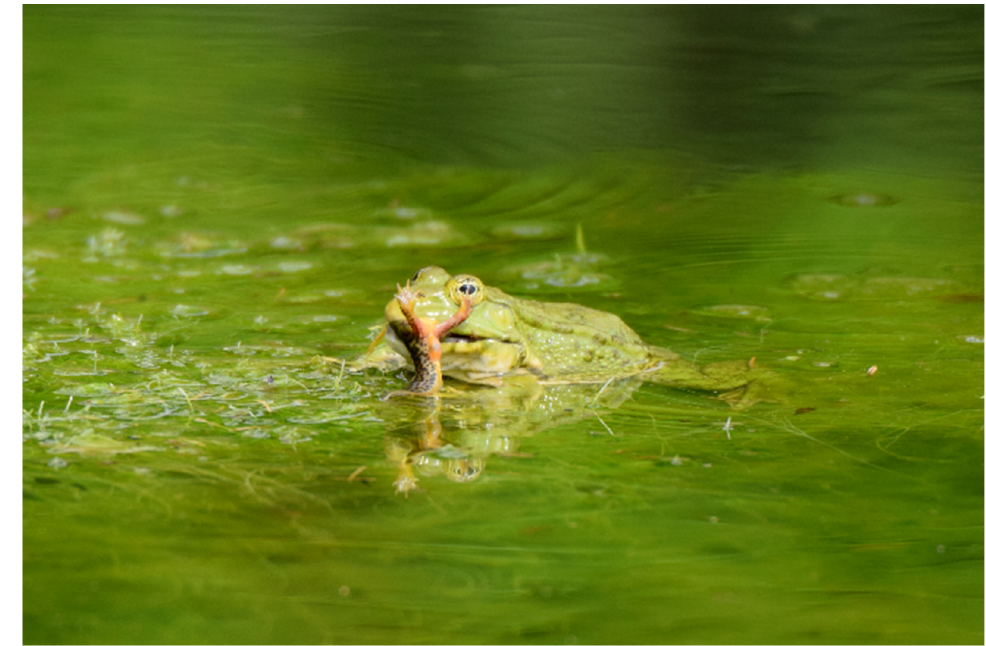
Figure 1. Marsh frog ( Pelophylax ridibundus ) preying on an adult palmate newt ( Lissotriton helveticus ) in a pond of the Larzac Plateau. Photography by V. Renard.